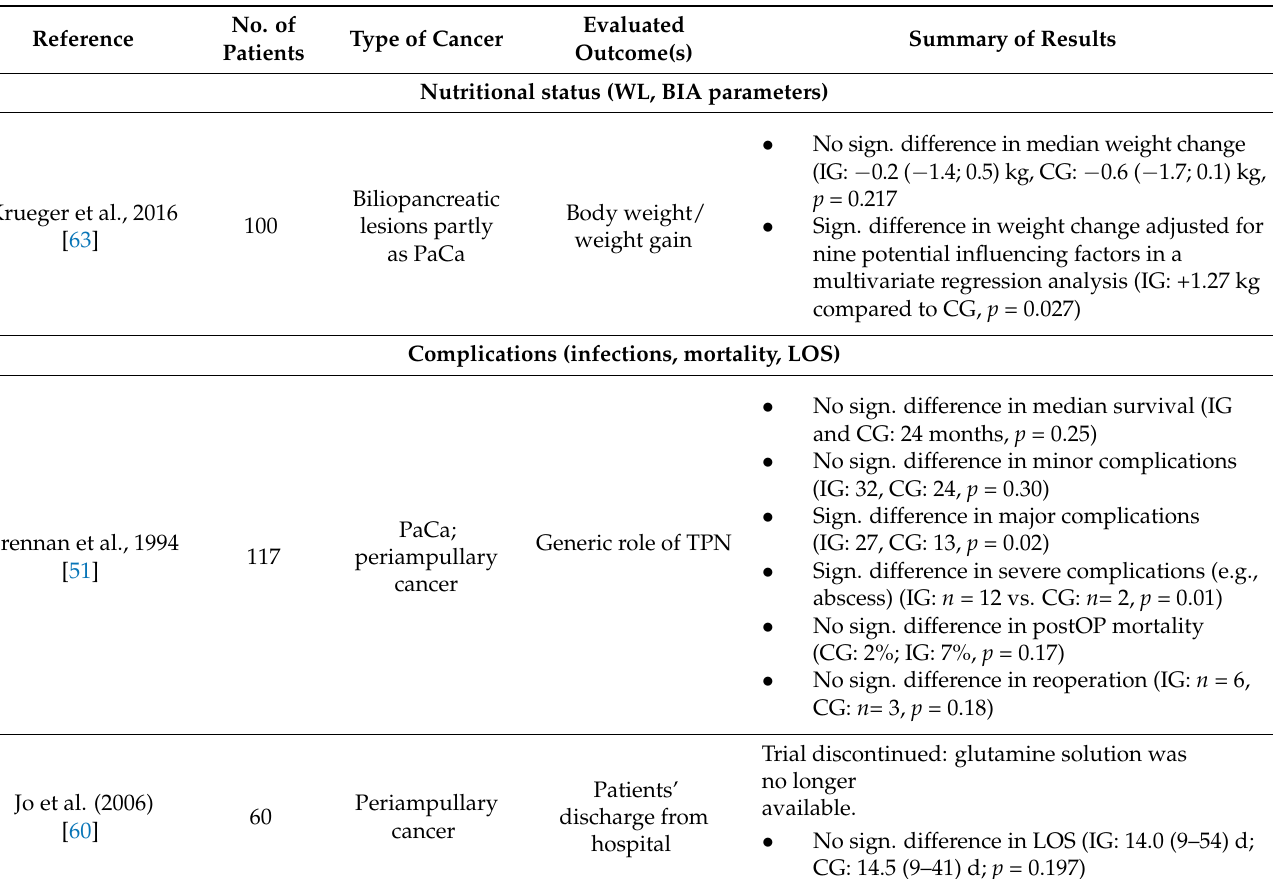
Table 2. Randomized controlled trials of parenteral